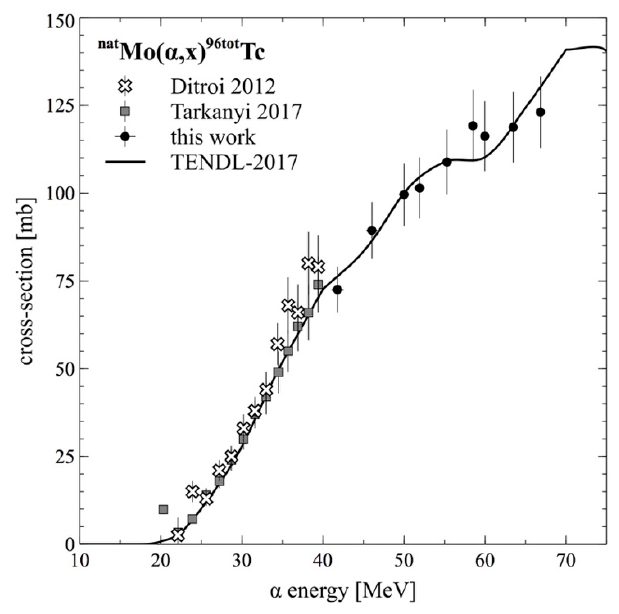
Figure 5. Measured cross-section for nat Mo( ⍺ ,x) 96tot Tc reaction compared with the literature. This is a cumulative cross-section of nat Mo( ⍺ ,x) 96g Tc and nat Mo( ⍺ ,x) 96m Tc reactions.